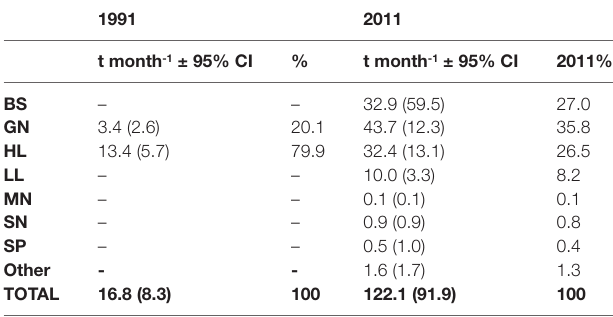
TABLE 1 | Comparisons of estimated average monthly catch (± 95% confidence interval) by fishing gear between 1991 (Laroche et al., 1997) and 2011.